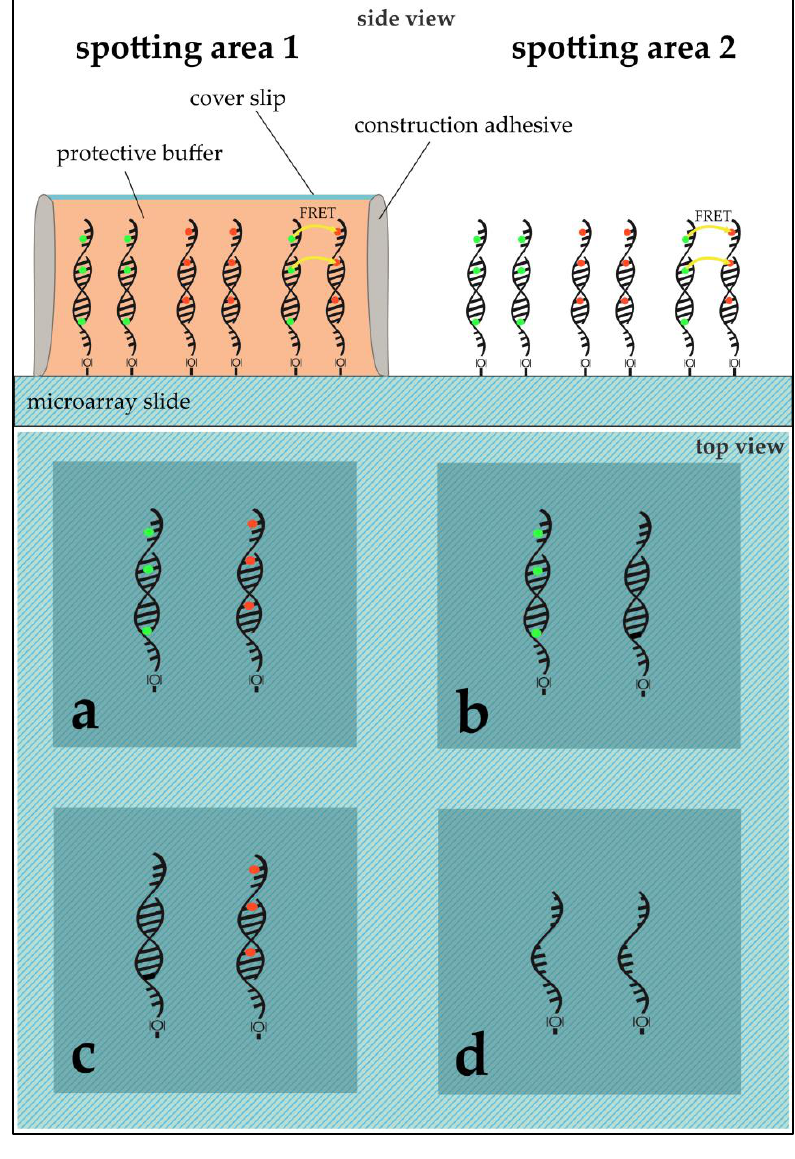
Figure 3. Microarray modified glass slide scheme for ROXS and FRET assessment. The slide shows two main spotting areas ( 1 , 2 ), each subdivided into four blocks ( a – d ). Each block was used to immobilize either 96 capture-oligos without replication or 24 capture-oligos with five replicates (six spots per gene). While ( a ) was used to hybridize Cy3- and Cy5-labeled cDNAs competitively; ( b ) for Cy3 vs. unlabeled cDNA; ( c ) for unlabeled vs. Cy5; and ( d ) was used as a negative control, where no hybridization took place. In the case of subsequent application of a protective cover slip, area 1 remained unprotected while area 2 was modified using a desired buffer and a cover slip (see Application of PBS and/or ROXS-Buffer ).